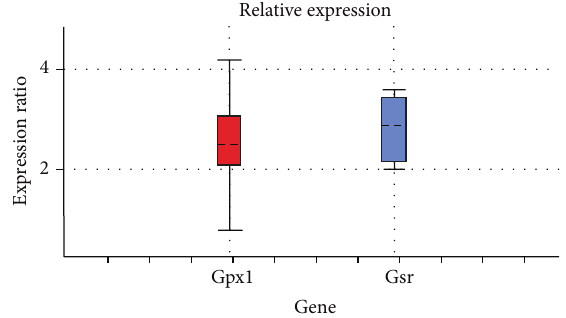
Figure 4: The level of Gsr and Gpx1 gene transcription in rat liver at 96h of toxic hepatitis development, calculated using the Rest 2008 software (the arrow shows the median of statistical distribution).